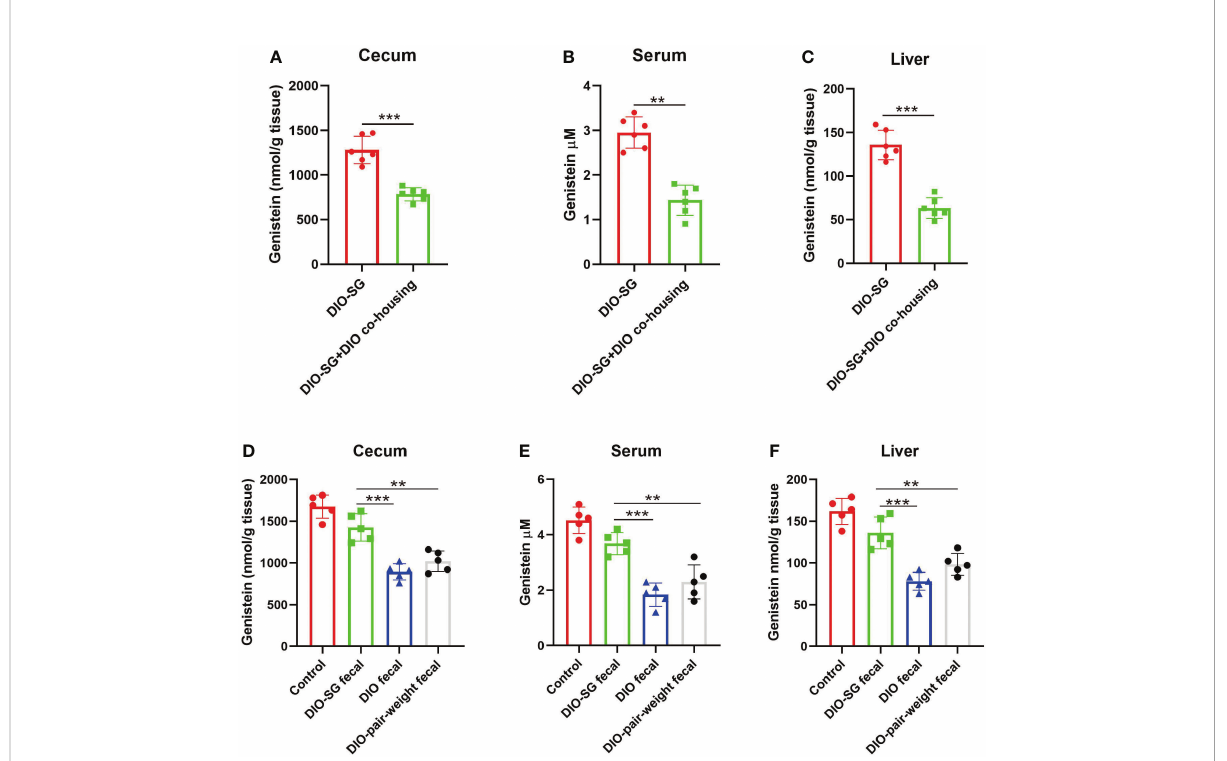
FIGURE 6 Transplantation of feces from SG mice could induce GE abundance in recipient mice. (A – C) Genistein concentrations in cecum, serum, and liver in different groups. n = 6. DIO-SG group: DIO mice underwent SG and fed alone in one cage. DIO-SG+DIO cohousing group: DIO mice underwent SG and cohoused with DIO mice (3 + 3 in one cage) for 6 weeks. (D – F) Genistein concentrations in cecum, serum, and liver in different groups. n = 5. There are four groups, in each group the normal-diet-fed mice are recipient mice and received oral gavage of feces from SG mice (DIO-SG fecal group), DIO mice (DIO fecal group), and pair-weight mice (DIO-pair-weight fecal group). The control group contains fi ve mice which were fed with a normal diet and did not receive oral gavage. ANOVA test was used to compare the differences among the groups. Mann – Whitney U test was used to analyze the differences between the two groups. Data are presented as mean ± SEM, ** stands for p < 0.01, and *** stands for p <